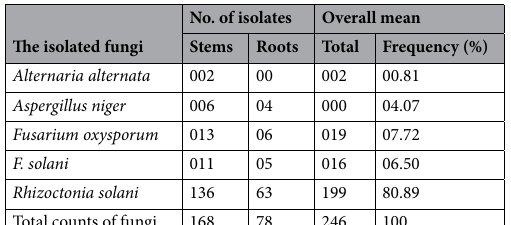
The isolated fungi